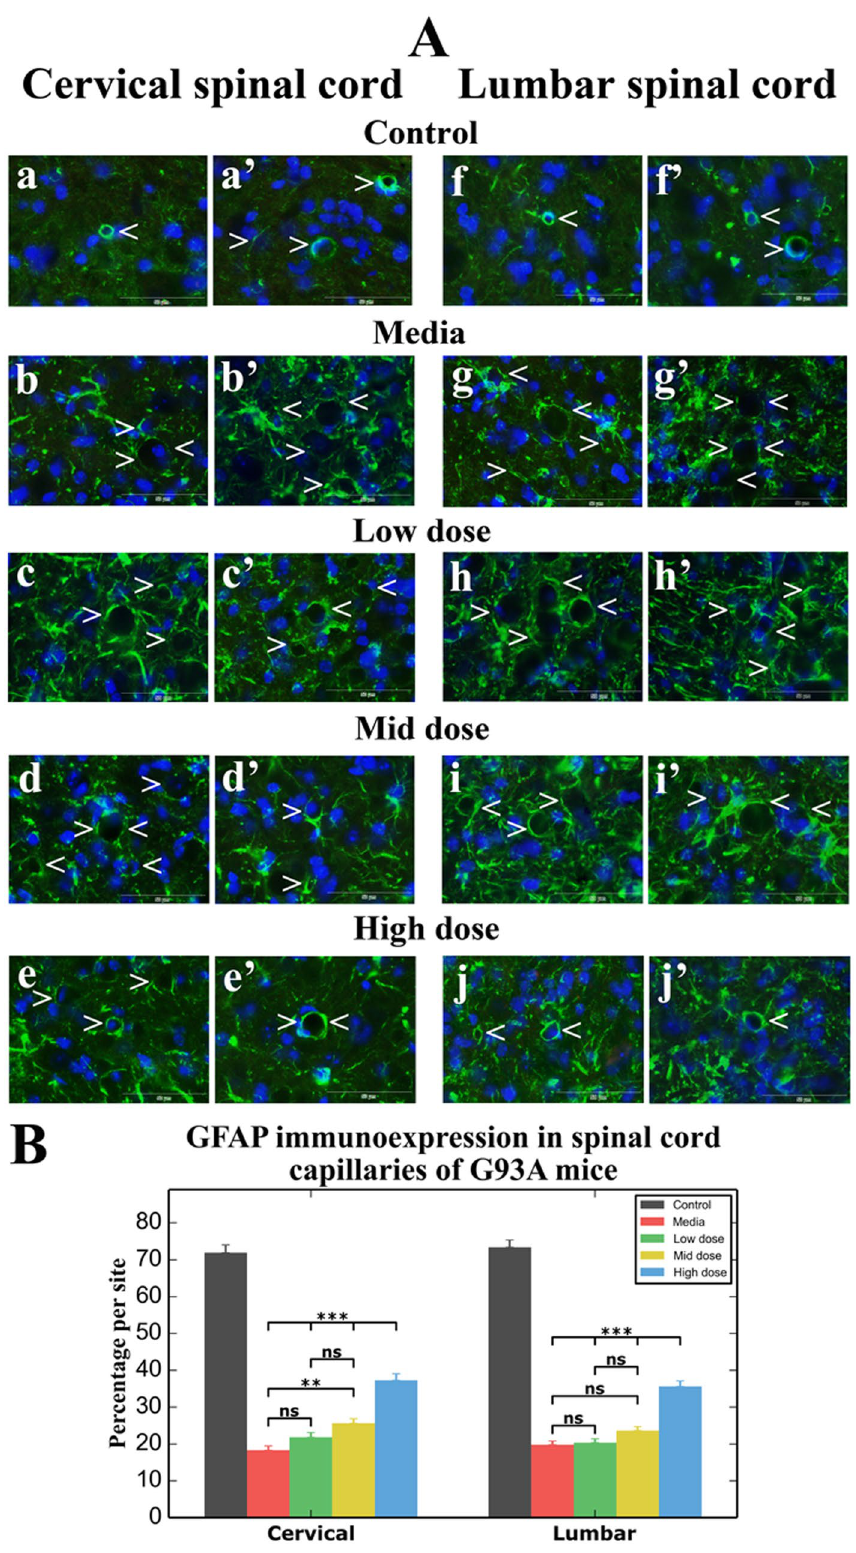
Figure 6. Characteristics of perivascular astrocytes in the cervical and lumbar spinal cord of G93A mice. ( A ) Immunohistochemical staining of perivascular astrocytes with GFAP antibody (green) in control mice showed normal appearance of delineated astrocytes covering capillaries in the cervical (a,a’, arrowheads) and lumbar (f,f’, arrowheads) spinal cords. In media-injected mice, perivascular astrocytes surrounding capillaries were partially revealed in both the cervical (b,b’, arrowheads) and lumbar (g,g’, arrowheads) spinal cords. There were no substantial differences in perivascular astrocyte GFAP expressions in cervical (low dose; c,c’; mid dose: